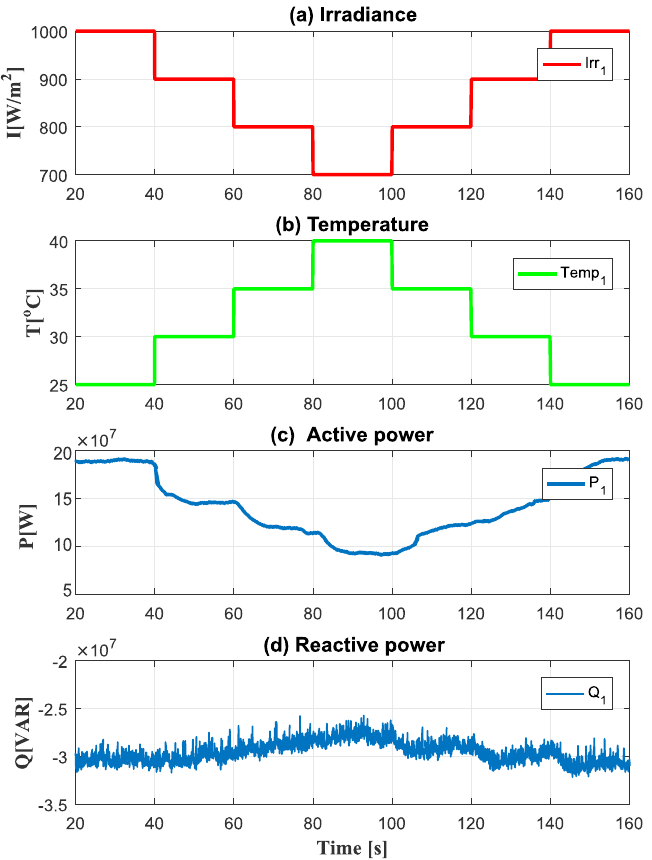
Figure 9. PV Array 1 variables: ( a ) Irradiance, ( b ) temperature, ( c ) active power, and ( d ) reactive power.